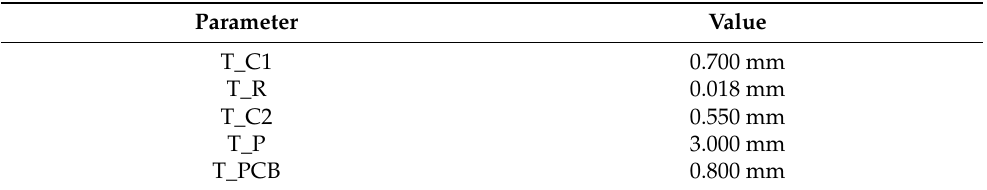
Table 1. The physical dimensions of the initial geometry of the proposed